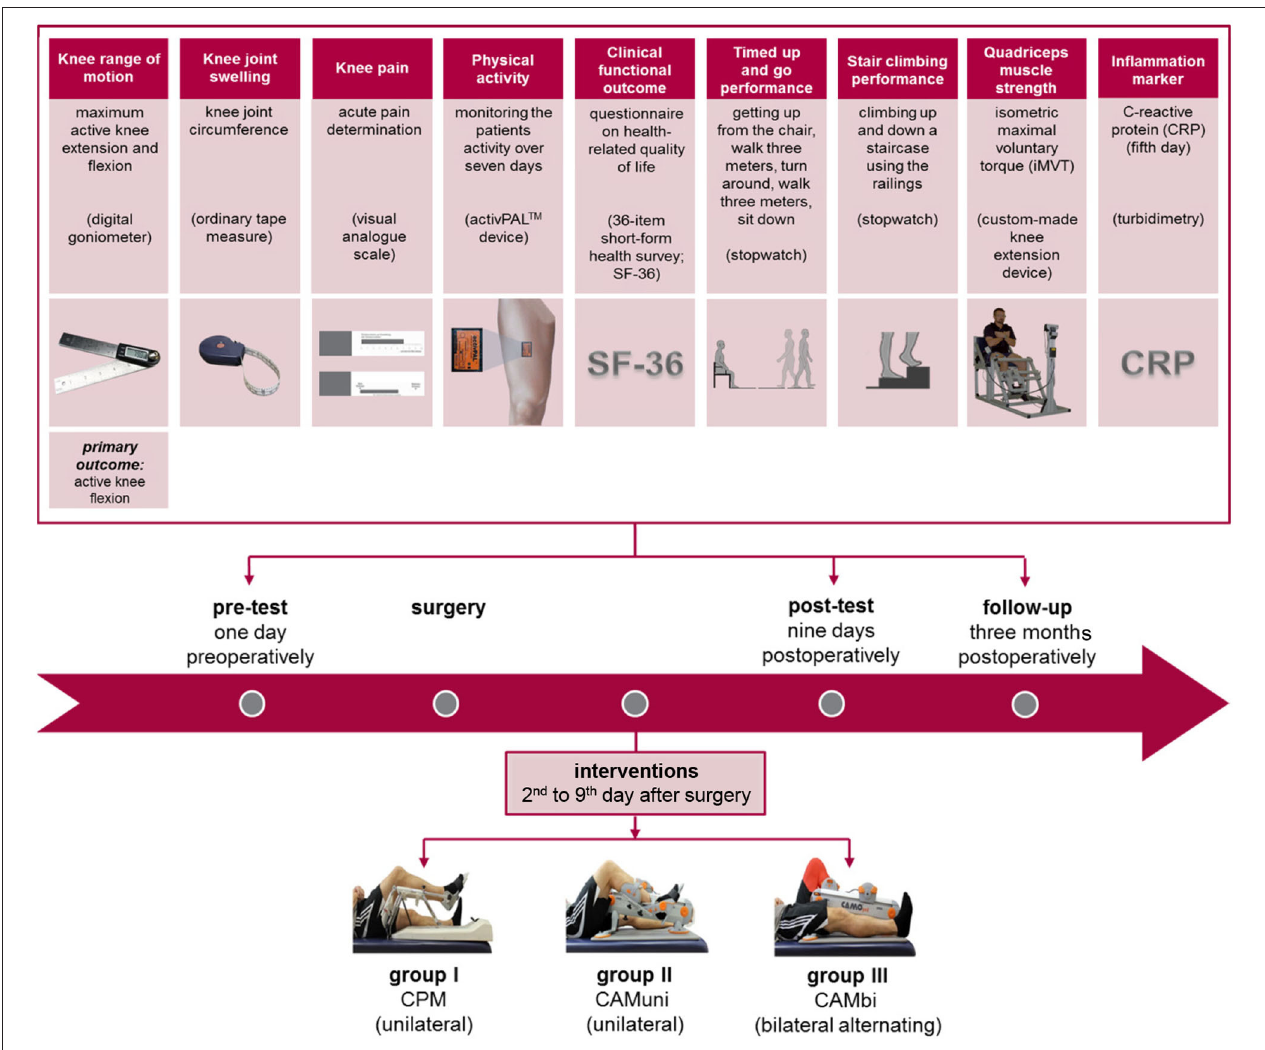
FIGURE 1 | Overview of groups, interventions, measuring points, and relevant primary and secondary